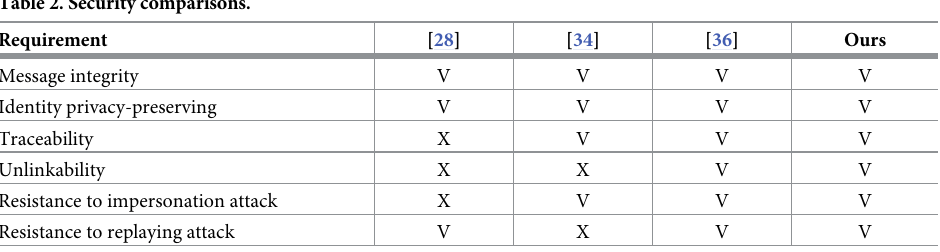
Table 2. Security